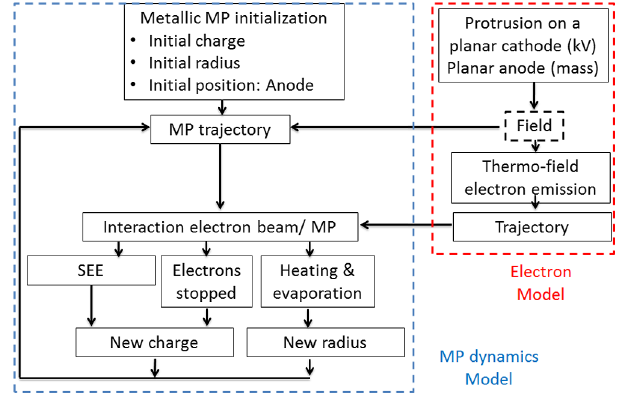
FIG. 10. Model flowchart of the 3D MP dynamics. Two models are connected, one corresponds to thermofield electron emission from an apex (red) and the second to the MP trajectory (blue). SEE denotes the secondary electron